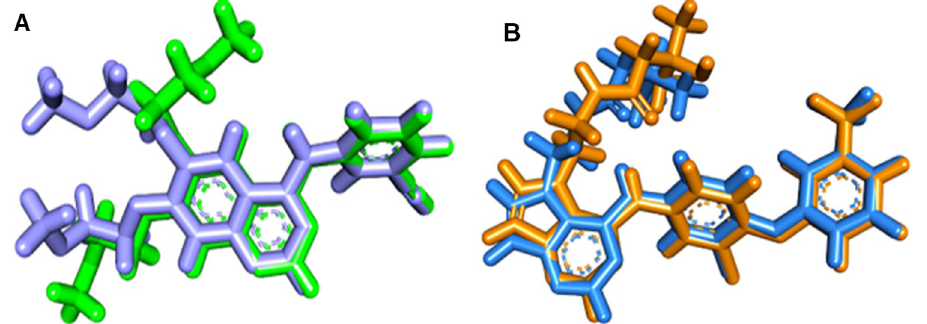
Fig 3. A: Validation of wild EGFR using erlotinib as co-crystallized ligand and B: Validation of mutant EGFR using TAK-285 as co-crystallized